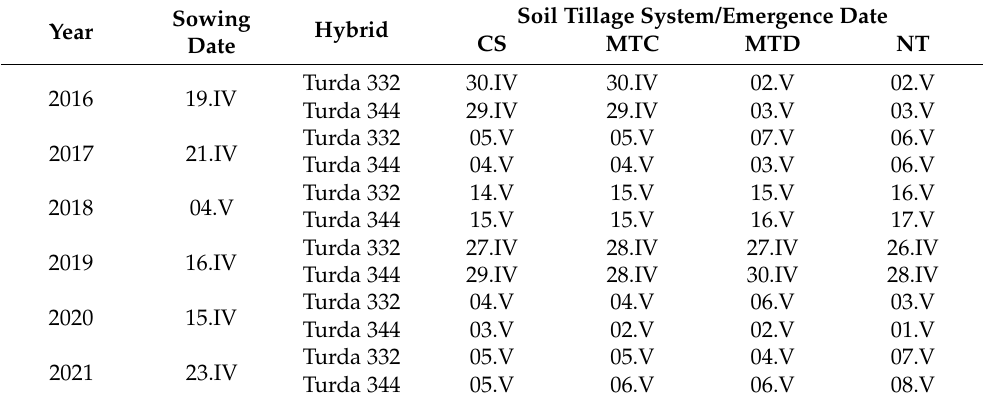
Table 3. The emergence of the maize crop depending on the tillage variant, 2016 – 2021.